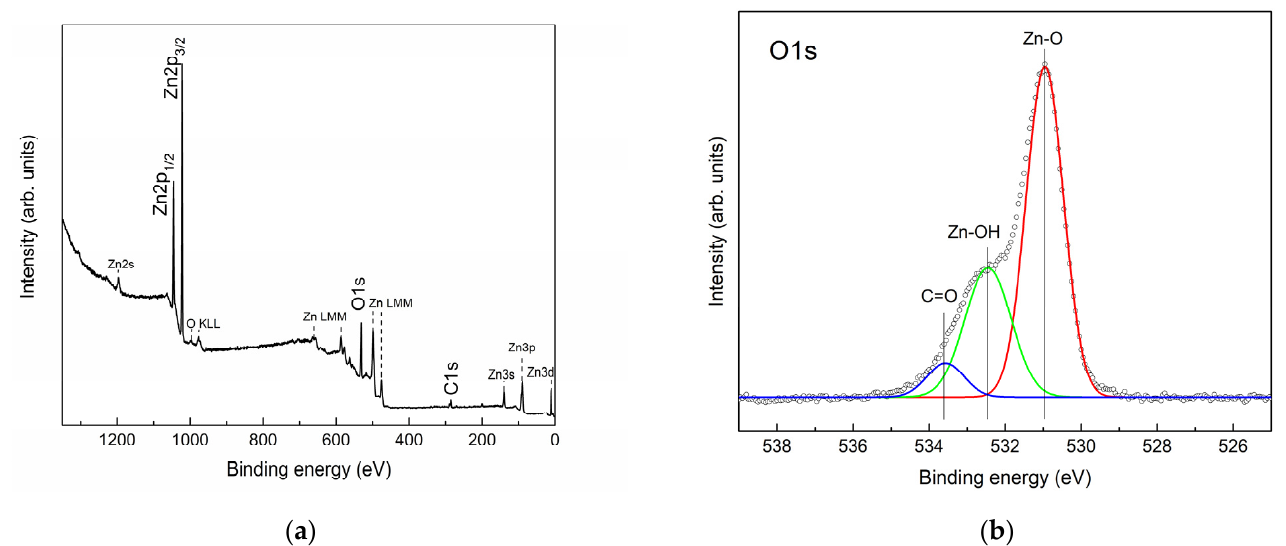
Figure 7. XPS spectra of the surface of ZnO nanorods: ( a ) survey spectrum of the ZnO surface; ( b ) spectrum of the core oxygen level, O1s.